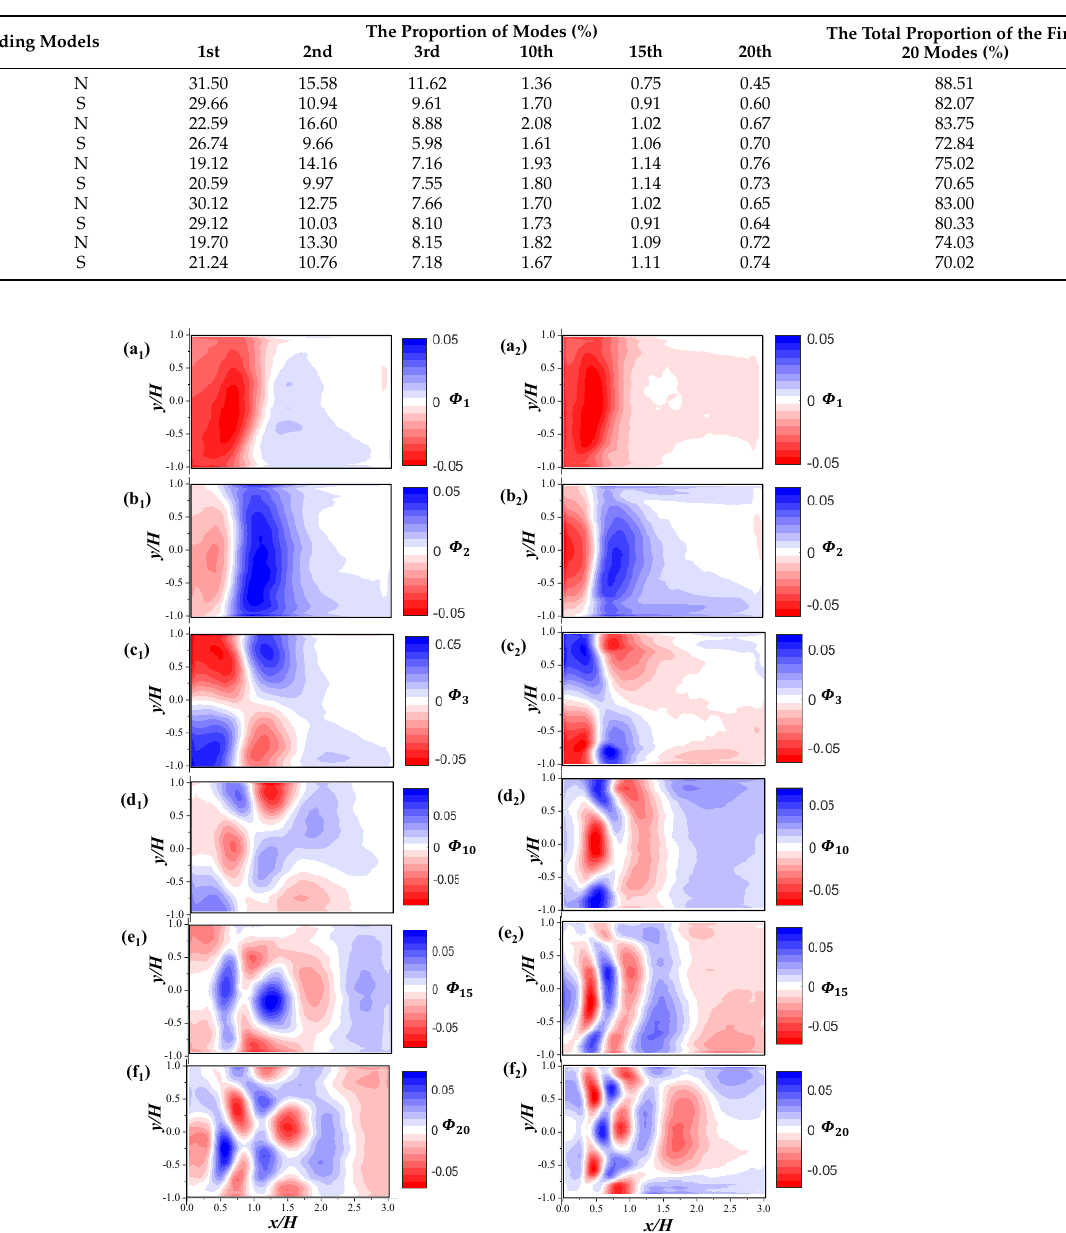
Table 3. Proportion and cumulative proportion of the energy level corresponds to the POD modes.